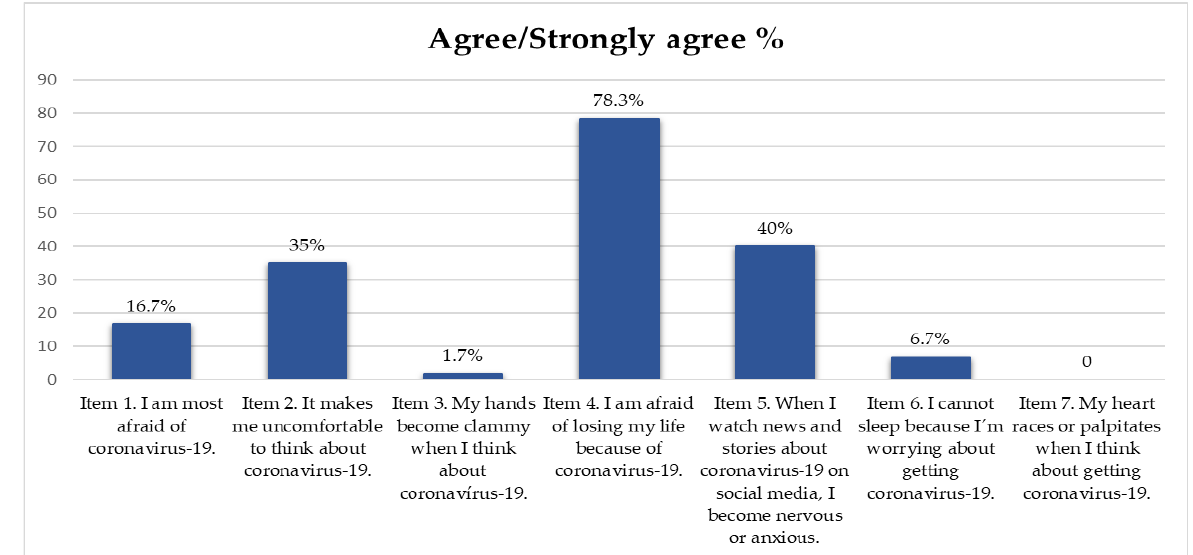
Figure 1. Inmates’ agreement on the seven items of FCV-19S.